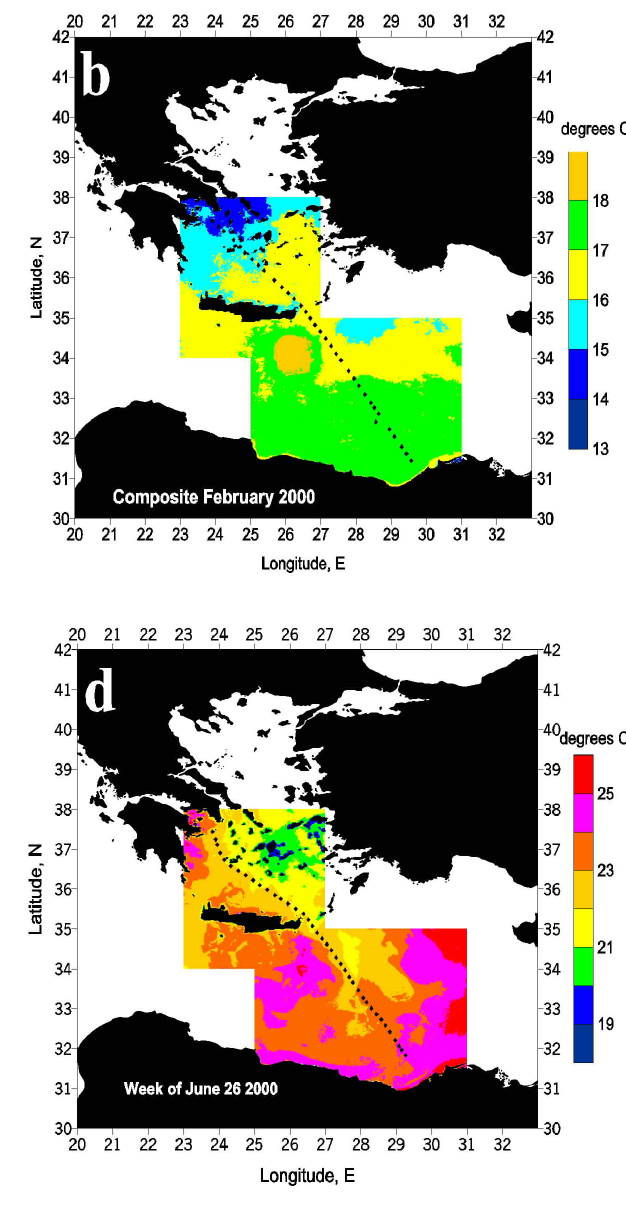
Fig. 4. Sea surface temperature distribution in (a) December 1999, (b) February, (c) May and (d) June